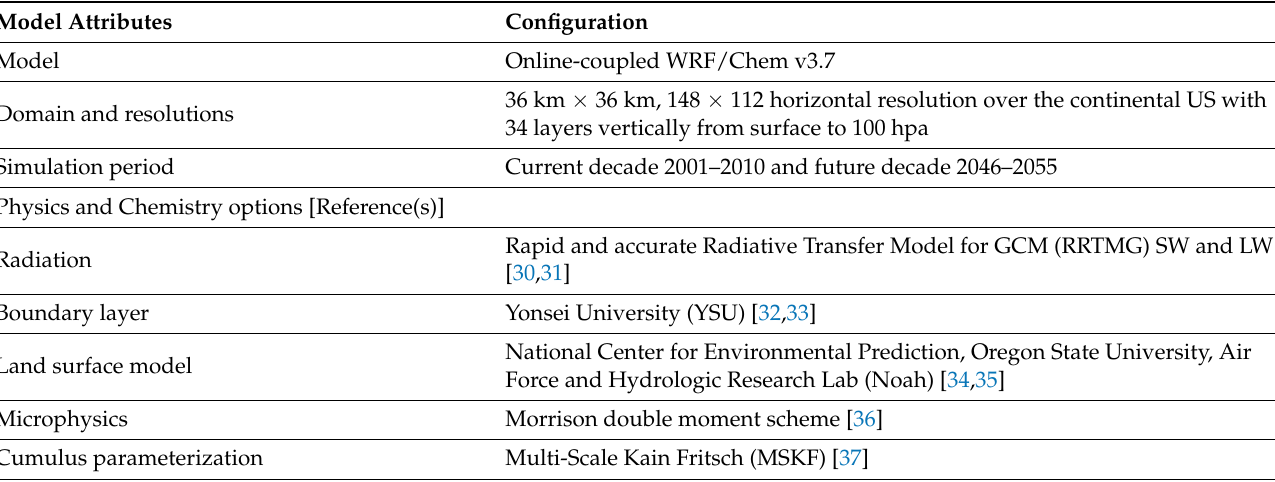
Table 2. WRF/Chem model configuration, physics and chemistry options, and major inputs used in this